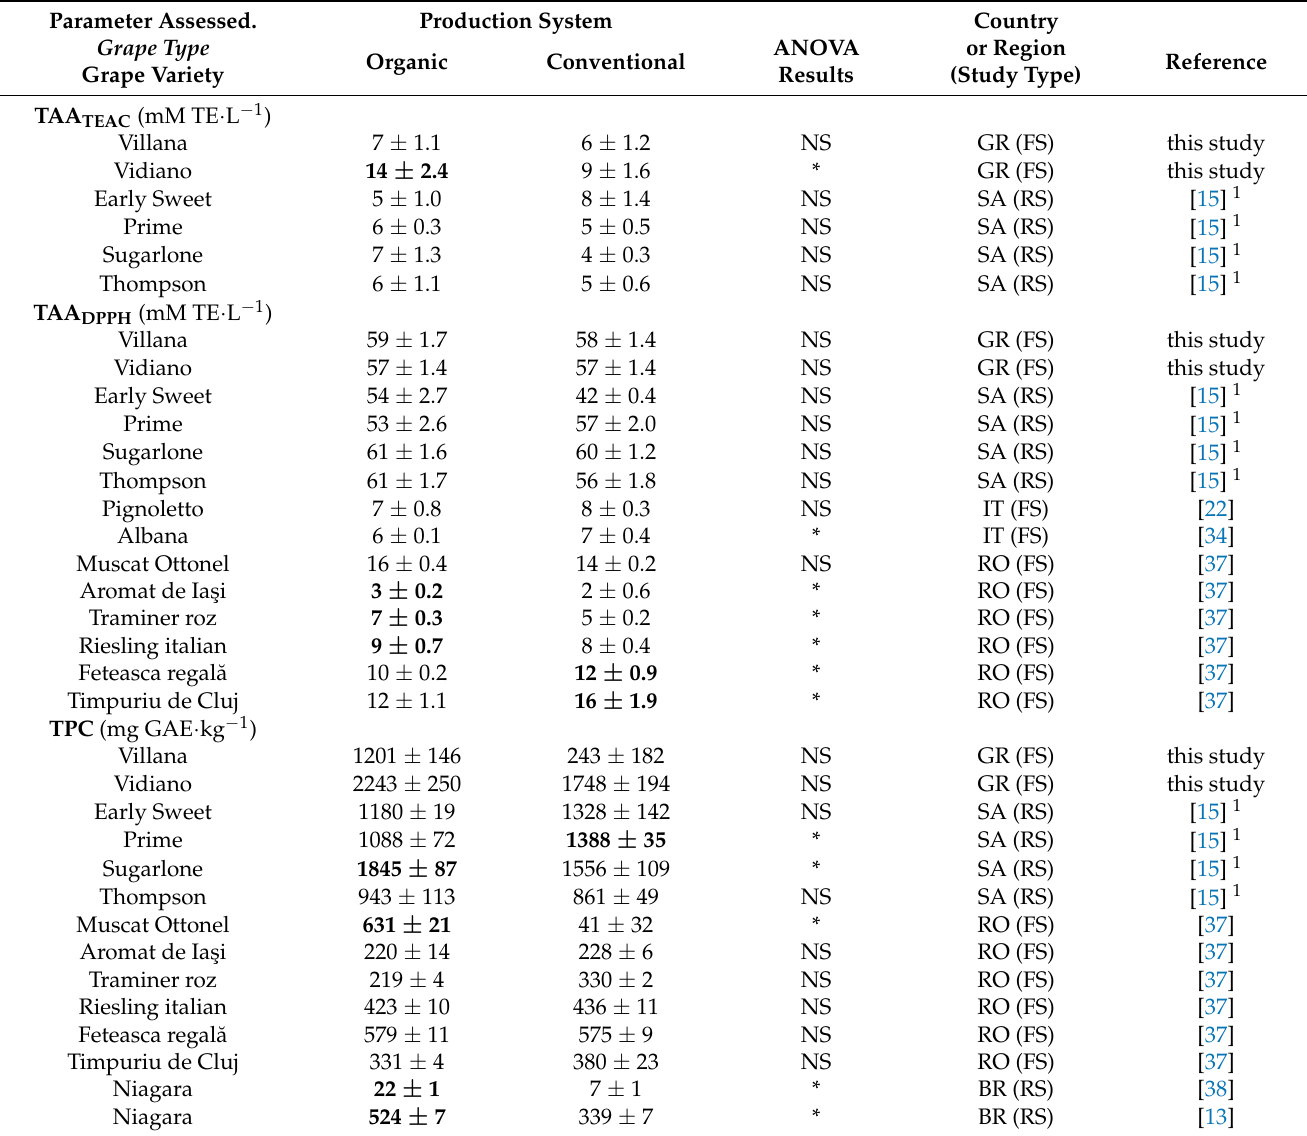
Table 3. Antioxidant activity/capacity (TEAC and DPPH assays), total phenolic content (TPC), and total anthocyanin content (TAC) reported for different white grape varieties grown in organic and conventional production systems in different